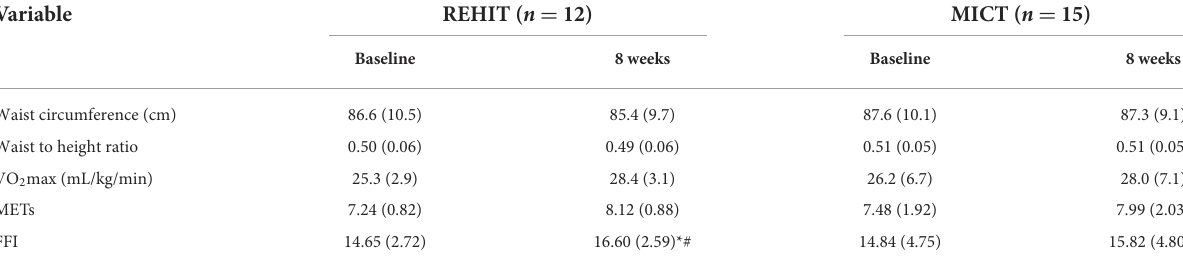
TABLE 2 Outcome measures of participants at baseline and post 8 weeks of intervention.